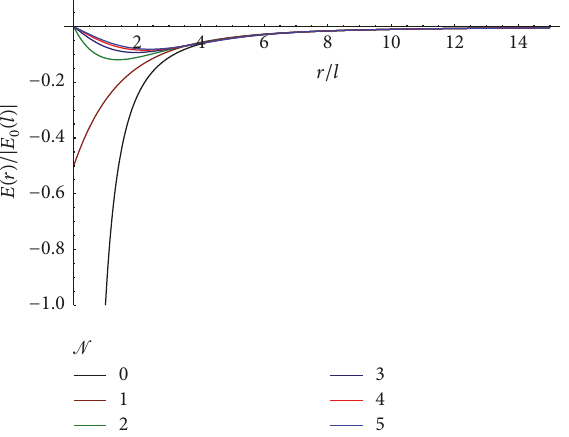
Figure 3: The nonrelativistic gravitational potential energy for different values of N . We have defined 𝐸 0 (𝑙) = −𝐺𝑀 1 𝑀 2 /𝑙 .